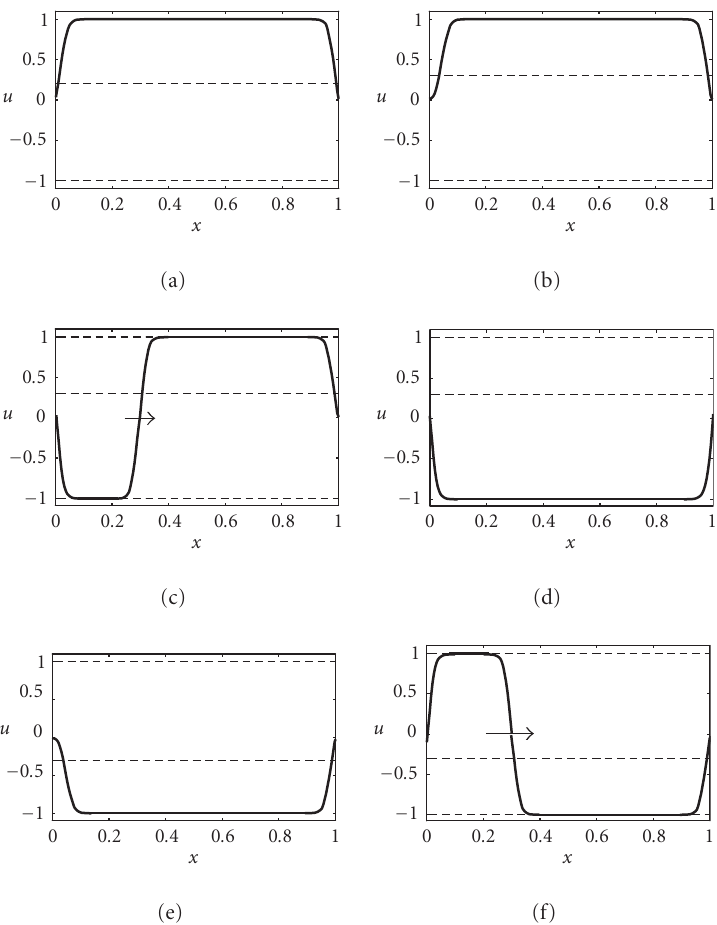
Figure 3.6. Sample phases of the periodic solution behavior illustrating the switching between the upper and the lower boundary layer type solutions. Now the transition always starts at the left end point of the spatial interval x ∈